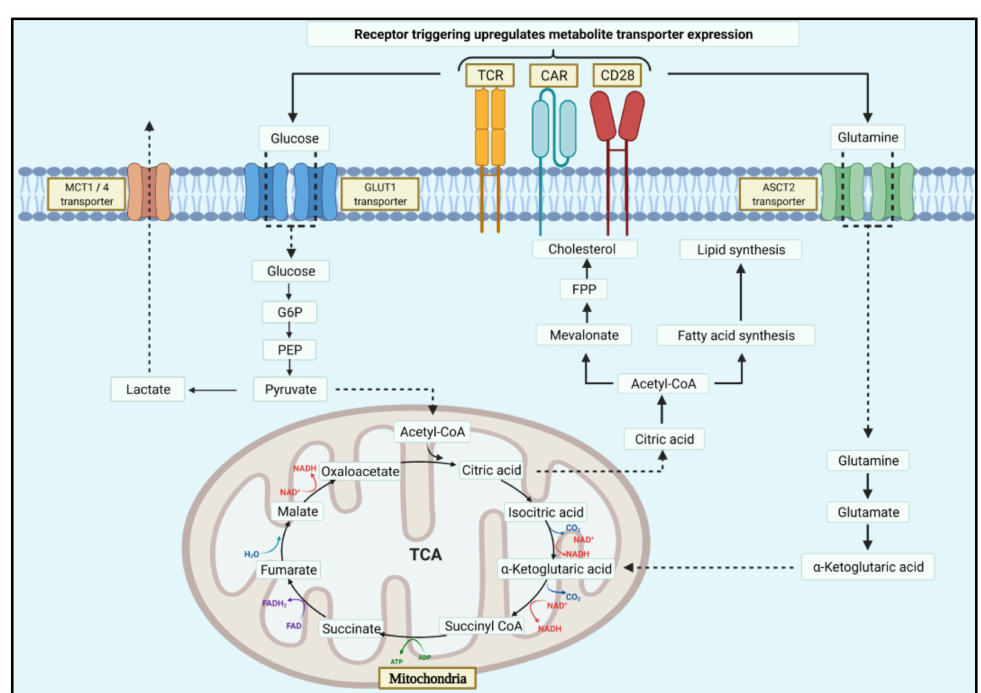
Figure 1. Schematic diagram of metabolic pathways in T cells. During T cell activation and rapid proliferation, glycolytic metabolism is enhanced by increases in glycolytic transporters such as GLUT- 1. This increases glycolytically derived pyruvate conversion to acetyl-CoA, which is further converted to citrate within the TCA cycle. In the activated T cells, citrate is exported into the cytoplasm, where it is converted back to acetyl-CoA for use in the mevalonate pathway to synthesise cholesterol. To balance the export of citrate out of the TCA cycle, glutamine transporters are also upregulated. TCR, T-cell receptor; CAR, chimeric antigen receptor; MCT1, monocarboxylate transporter 1; GLUT1, glucose transporter 1; ASCT2, alanine-serine-cysteine transporter 2; G6P, glucose 6-phosphate; PEP, phosphoenolpyruvate; FPP, farnesyl diphosphate; TCA, Tricarboxylic acid